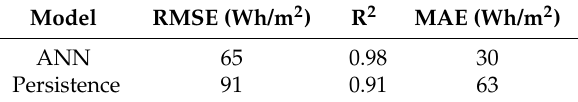
Table 5. Comparison of the statistical indicators of the ANN forecast model against the persistence forecast model on 17 July 2015 at 05:01 to 18:00.